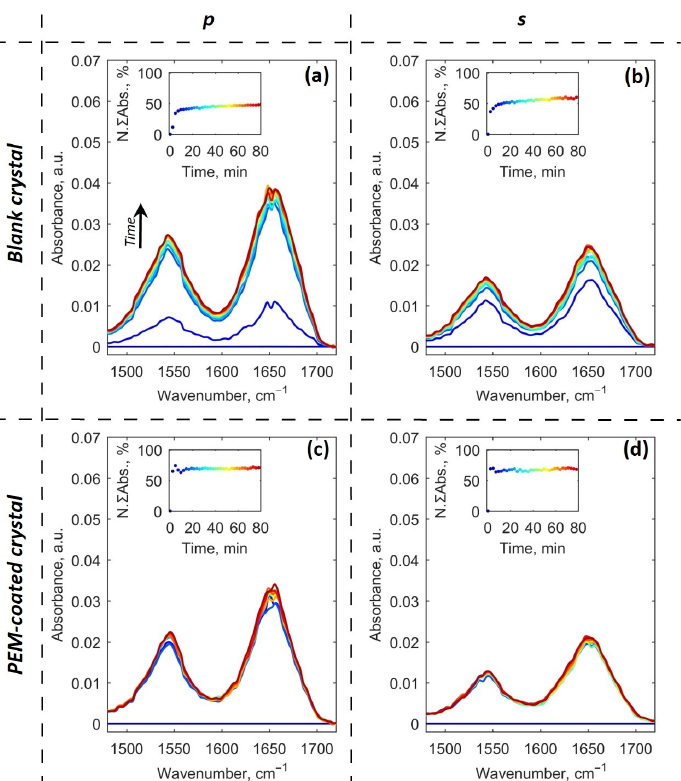
Figure 1. ATR-FTIR spectra recorded upon adsorption of Lys on the blank ( a , b ) and the PEM-coated ( c , d ) crystal for p ( a , c ) and s ( b , d ) polarization. The black arrow in a indicates the direction of the time span. Inset graphs represent the temporal evolution of the total absorbance normalized by the total absorbance of the last spectrum recorded during adsorption studies (see Materials and Methods). The colors of the presented data (from cold to warm) reflect the direction of the time span. The colors of the spectra correspond the colors of the data in the inset graphs.